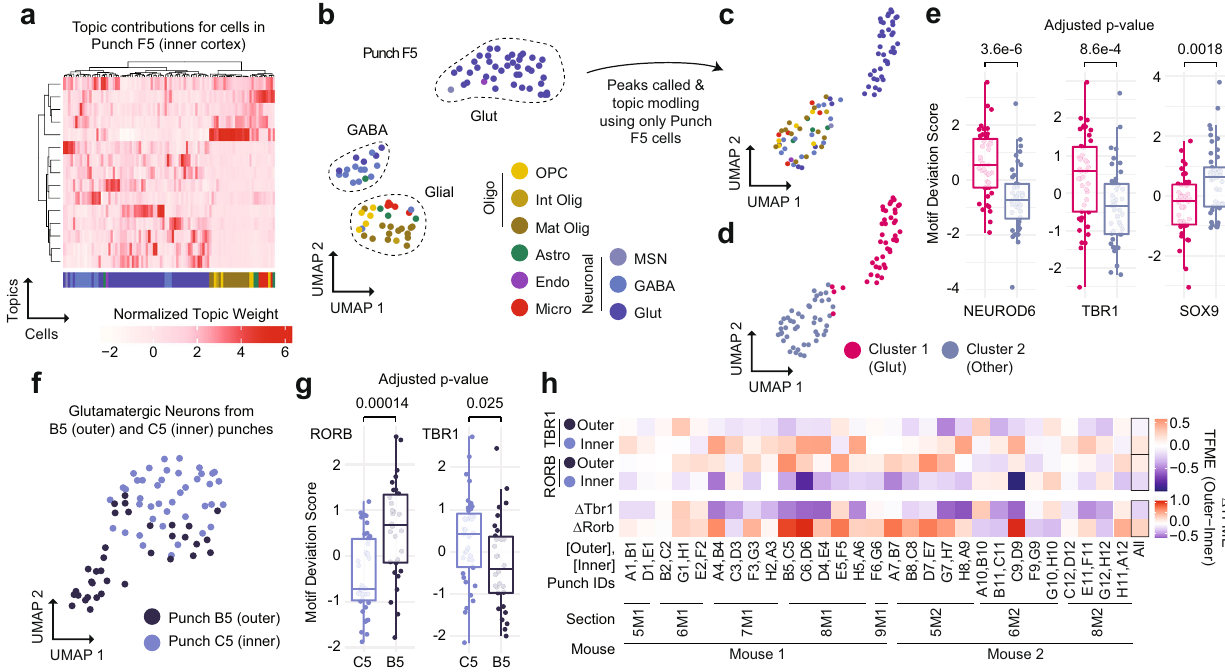
Fig. 3 sciMAP-ATAC enables the analysis and comparison of cells and cell types from individual spatial positions. a Topic weight matrix for cells present only in a single punch (F5, inner cortex punch), annotated by cell type (bottom); colored by cell type from the full dataset (Fig. 2d). b UMAP of cells from punch F5 showing spatially distinct groupings for cell type; colored by cell type from the full dataset (Fig. 2d). c Isolated analysis of cells from Punch F5 for peak calling, topic modeling, and visualized via UMAP; colored by cell type from the full dataset (Fig. 2d). d Two major clusters identi fi ed from the isolated analysis of punch F5 (Glut glutamatergic (excitatory) neurons). e Transcription factor motif enrichments for the isolated analysis of punch F5, indicating that cluster 1 ( n = 44 cells) is made up of glutamatergic neurons and cluster 2 ( n = 45 cells) is made up of other cell types. Center line represents median, lower, and upper hinges represent fi rst and third quartiles, whiskers extend from hinge to ±1.5 × IQR, individual cells represented as colored dots. f UMAP of all glutamatergic neuron cells from two adjacent punches (C5, inner cortex, and B5, outer cortex) after topic modeling on the isolated cell pro fi les. g Transcription factor motif enrichments for glutamatergic cells from adjacent punches from inner cortex ( n = 39 cells) and outer cortex ( n = 30 cells) shown in f ; colored by individual punch as in f . Two-sided Mann – Whitney U test with Bonferroni – Holm correction. Center line represents median, lower and upper hinges represent fi rst and third quartiles, whiskers extend from hinge to ±1.5 × IQR, individual cells represented as colored dots. h Motif enrichments across glutamatergic neurons across all punch pairs. TFME transcription factor motif enrichment. Source data are provided as a Source data fi